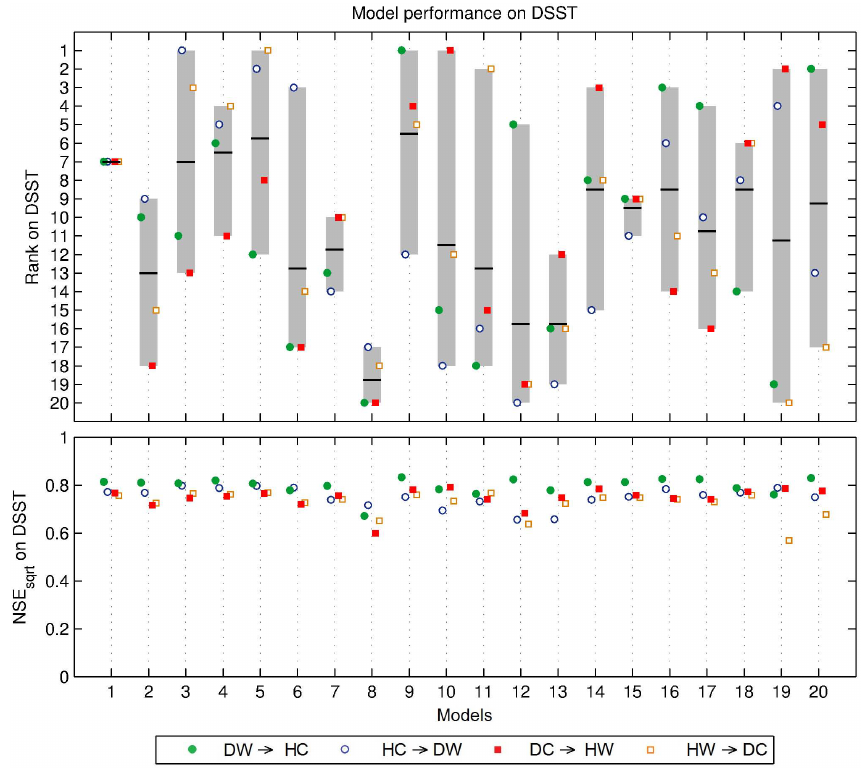
Fig. 6. Performance and rank in validation (NSE sqrt criterion) for the four DSST on the Au Saumon catchment